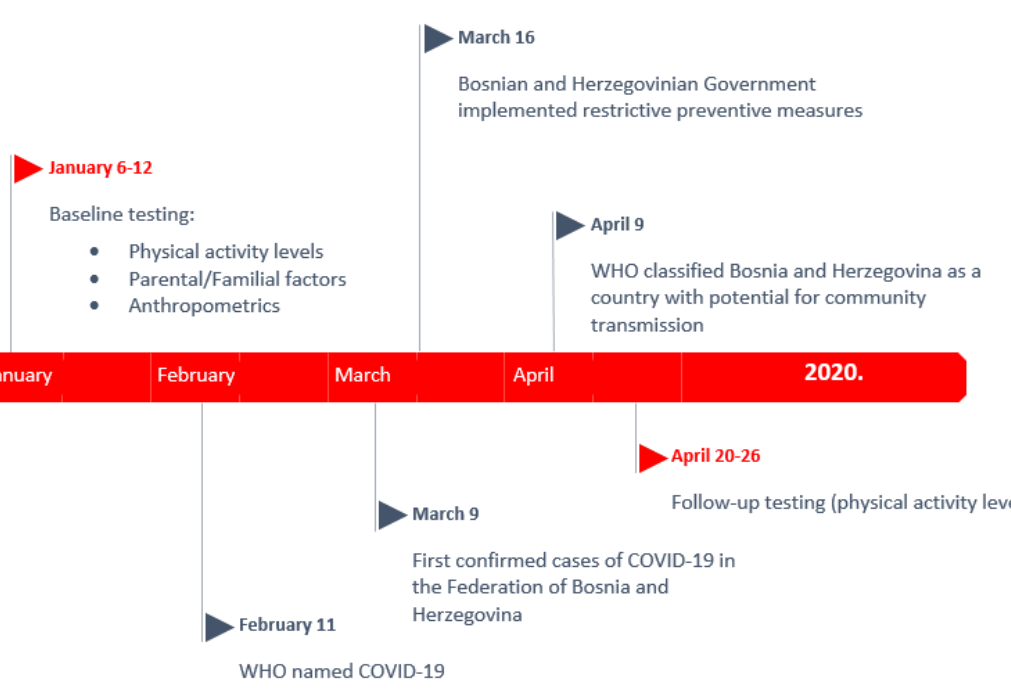
Figure 1. Time line of the investigation with the most important dates considering COVID-19 globally and in Bosnia and